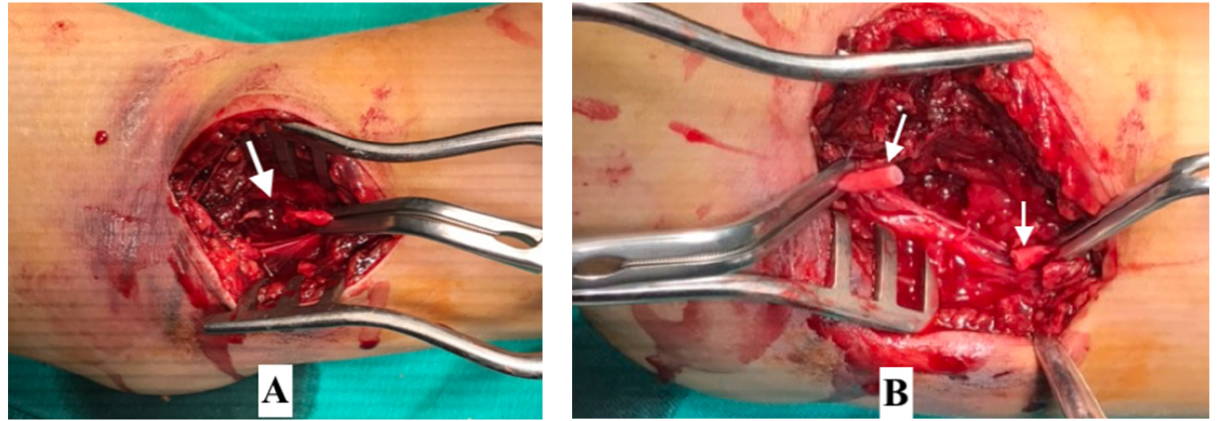
Figure 7. Physical injury to brachial artery and its surgical management. ( A ) Contusion, thrombosis and brachial artery nearly ruptured. ( B ) Damaged artery excised and directly anastomosed.